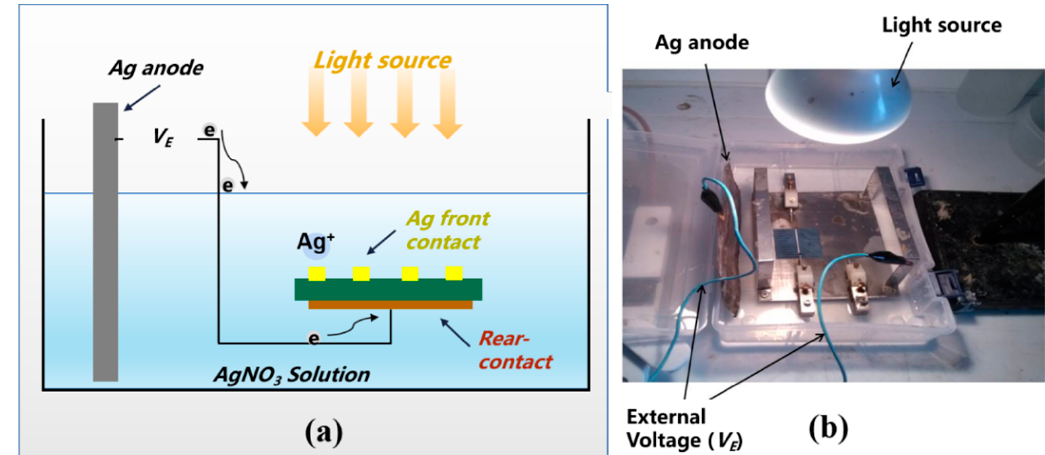
Figure 1. ( a ) The schematical principle of light-induced-plating. ( b ) Photograph of the LIP platform in our lab.